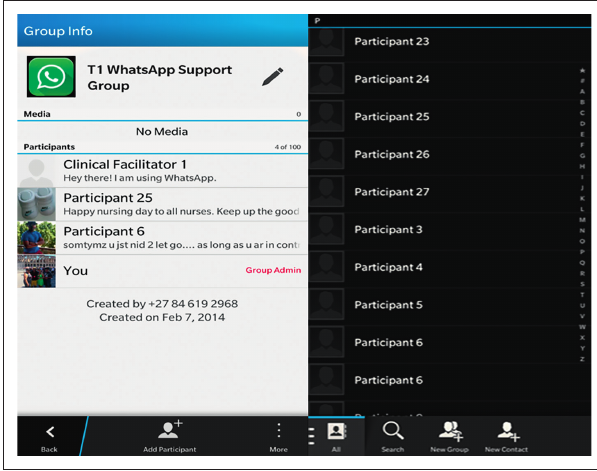
FIGURE 1: Anonymity within the WhatsApp